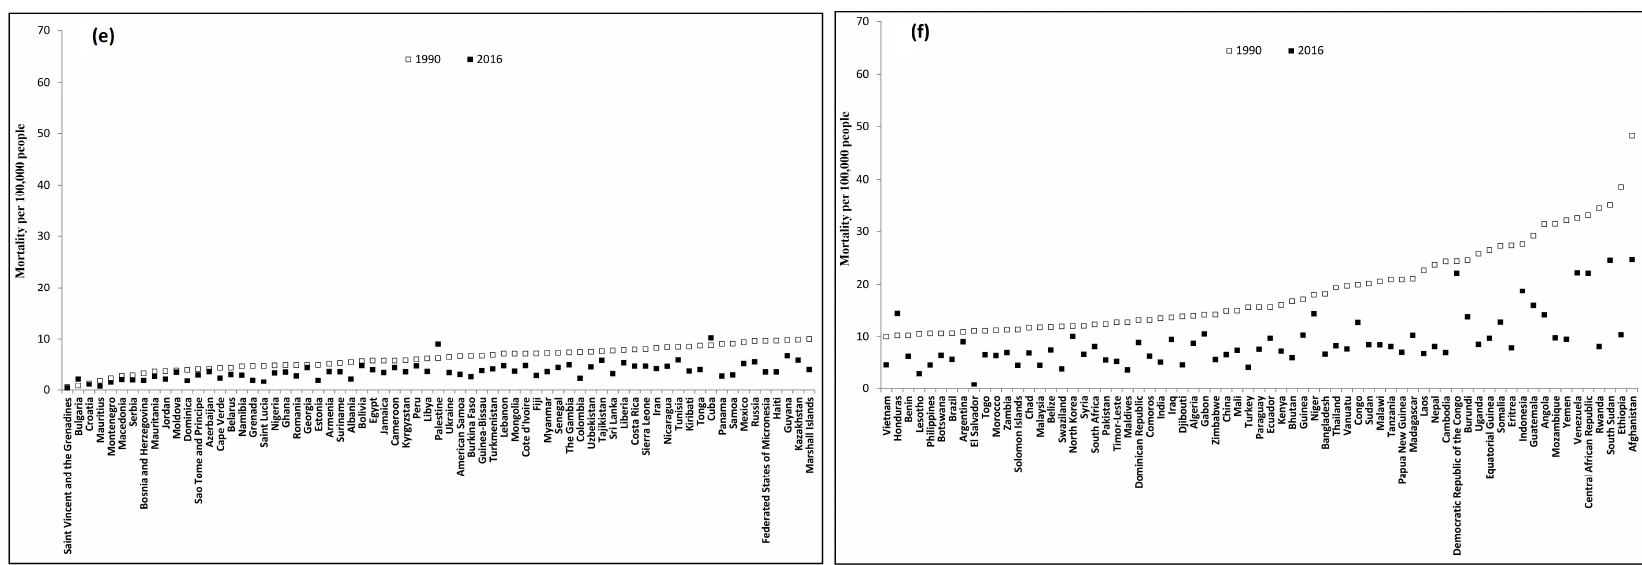
Figure 3. Country-specific unintentional occupational injury mortality of 196 countries between 1990 and 2016. ( a ) 15–49 years in HICs; ( b ) 50–69 years in HICs; ( c ) 15–49 years in LMICs; ( d ) 15–49 years in LMICs (continued); ( e ) 50–69 years in LMICs; and ( f ) 50–69 years in LMICs